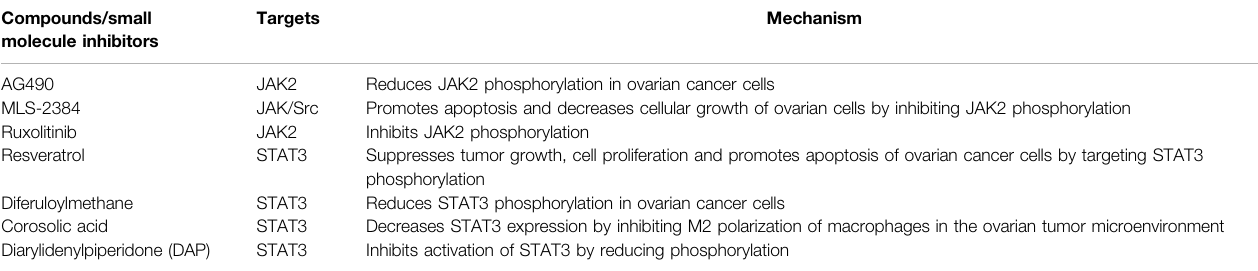
TABLE 7 | JAK/STAT signaling modulators, their targets, and mechanism in ovarian cancer/cells. Compounds/small molecule